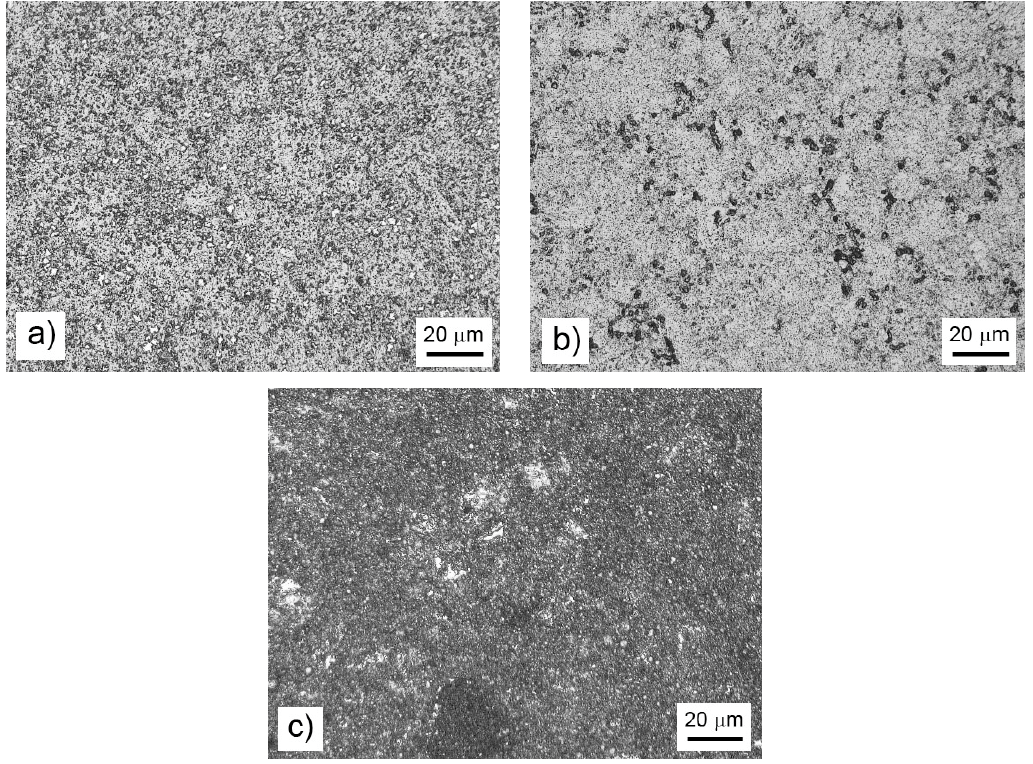
Figure 2. Microstructure of the bulk FeAl35Si5 alloy ( a ), the FeAl35Si5Ni20 alloy ( b ), and the FeAl35Si5Ti20 alloy ( c ) that were produced by mechanical alloying and spark plasma sintering.